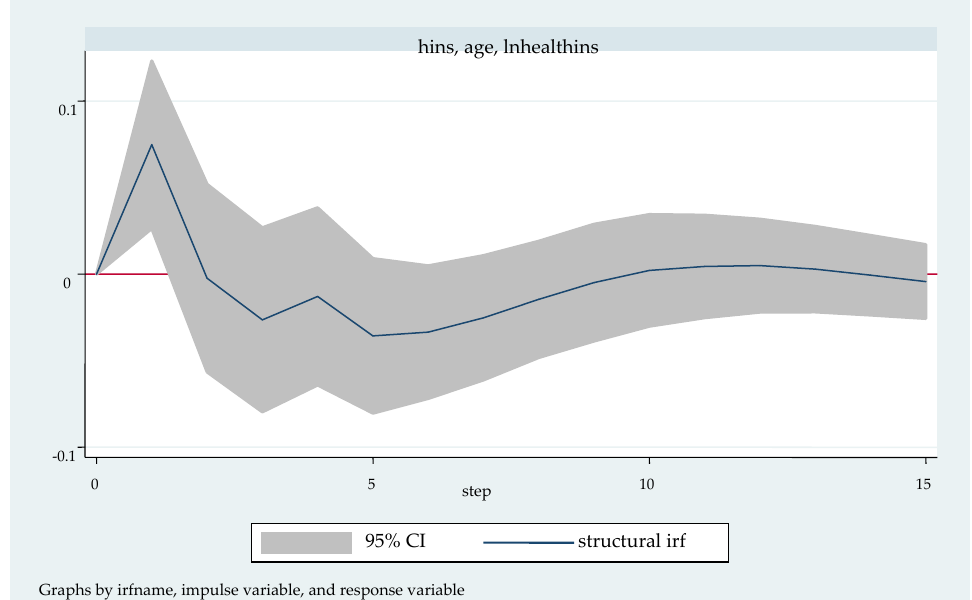
Figure 3. Impulse response function diagram of “lnhealthins” impacted by